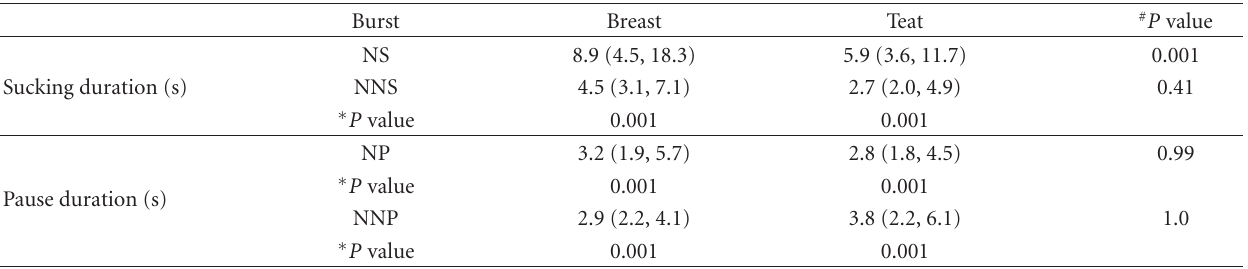
Table 4: Duration characteristics for the monitored breastfeed and the feed from the experimental